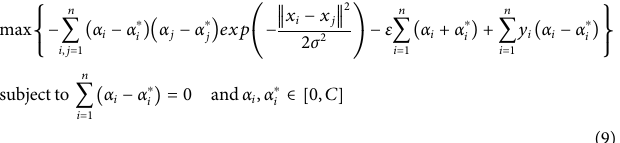
FIGURE 4 The process of training SVR using